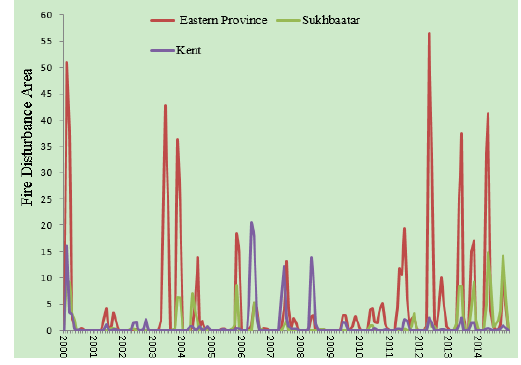
Figure 3. The Monthly (b) Distribution of